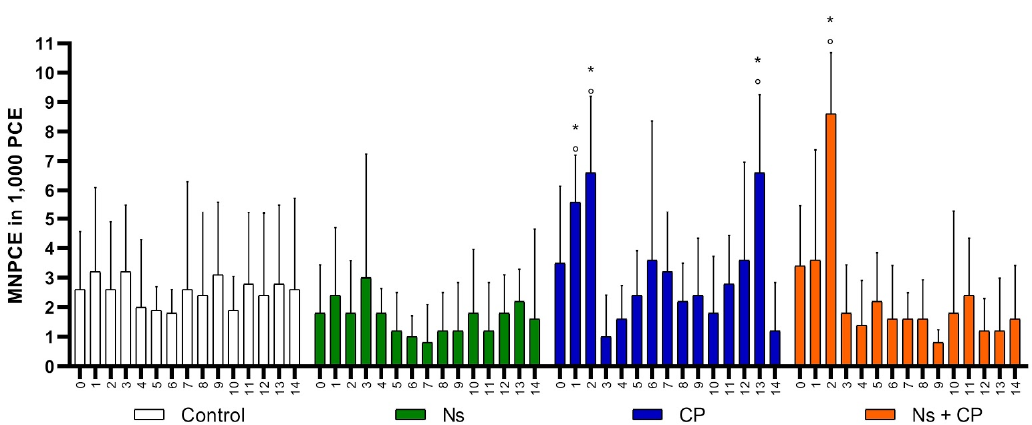
Figure 3. Mean and SD of Micronucleated Polychromatic Erythrocytes in study groups. (MNPCE- Micronucleated Polychromatic Erythrocytes; Ns- Nigella Sativa (500mg/kg); CP-Cisplatin (2mg/kg); X axis: Smear each day; °- p < 0.05 Intragroup comparison; *- p < 0.05 Intergroup comparison).